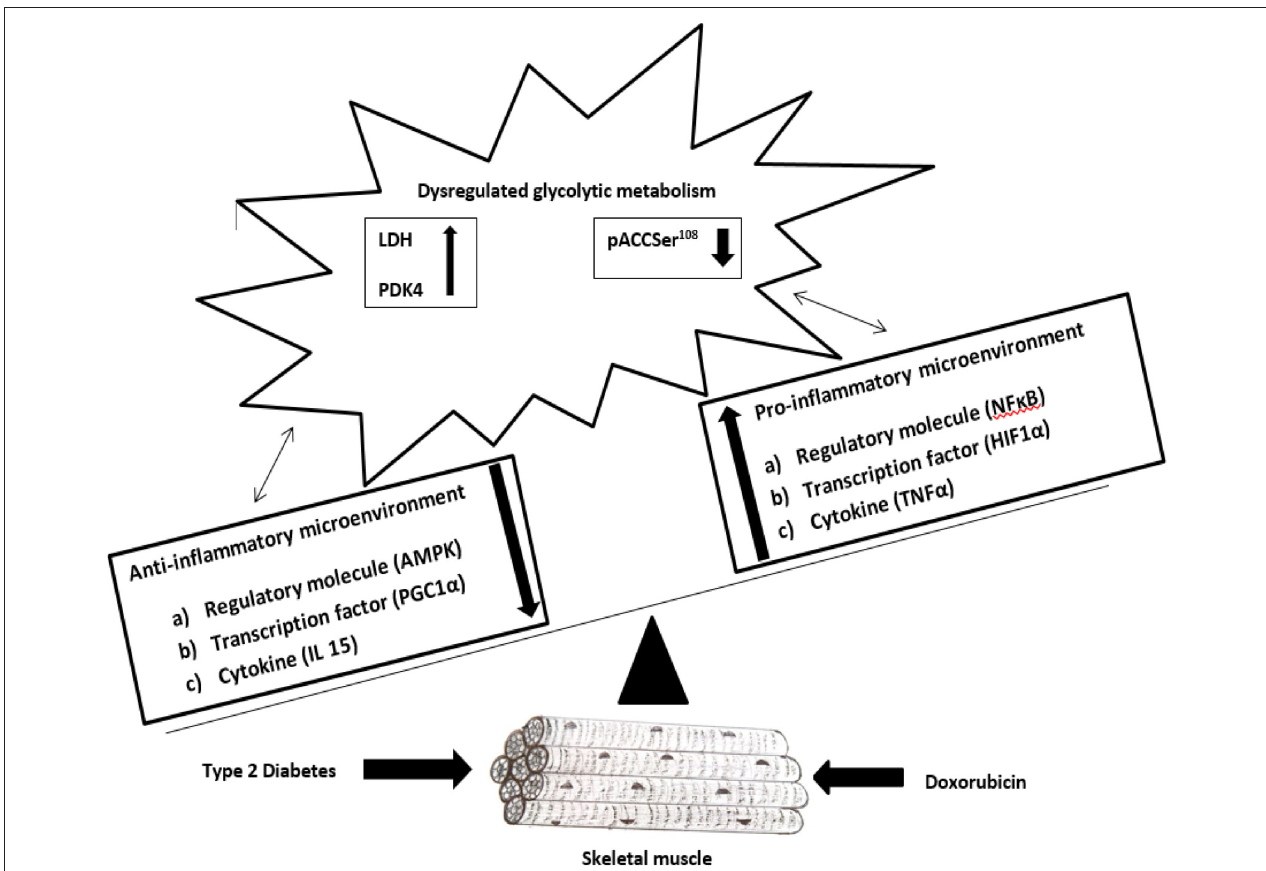
FIGURE 6 | DOX administration in diabetic skeletal muscle leads to upsurge of pro-inflammatory microenvironment (HIF1 α , NF κ B, TNF α ) along with upsurge of anaerobic glycolytic metabolic regulators (PDK4, LDH) and diminution of anti-inflammatory microenvironment (PGC1 α , AMPK, IL15) along with diminution of aerobic metabolic regulator (pACCSer 108